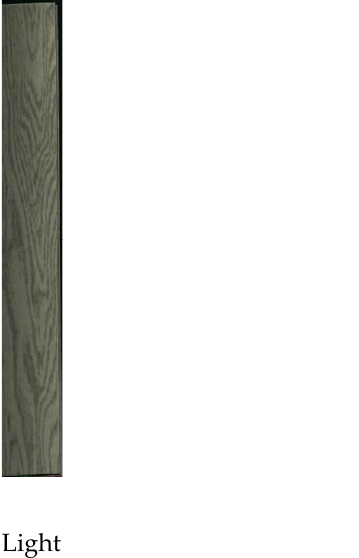
Table 1. Specific parameters of the CCD camera.